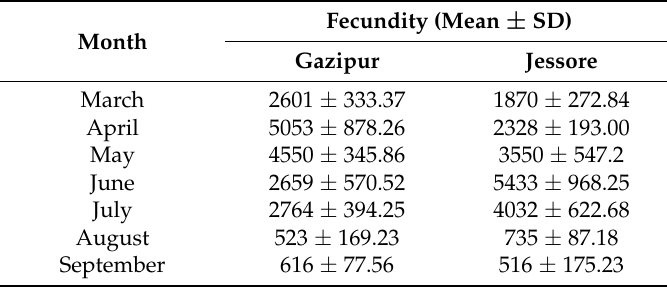
Table 3. Mean and standard deviation ( ± SD) of the fecundity of P. sophore in Gazipur and Jessore. Fecundity (Mean ± Month